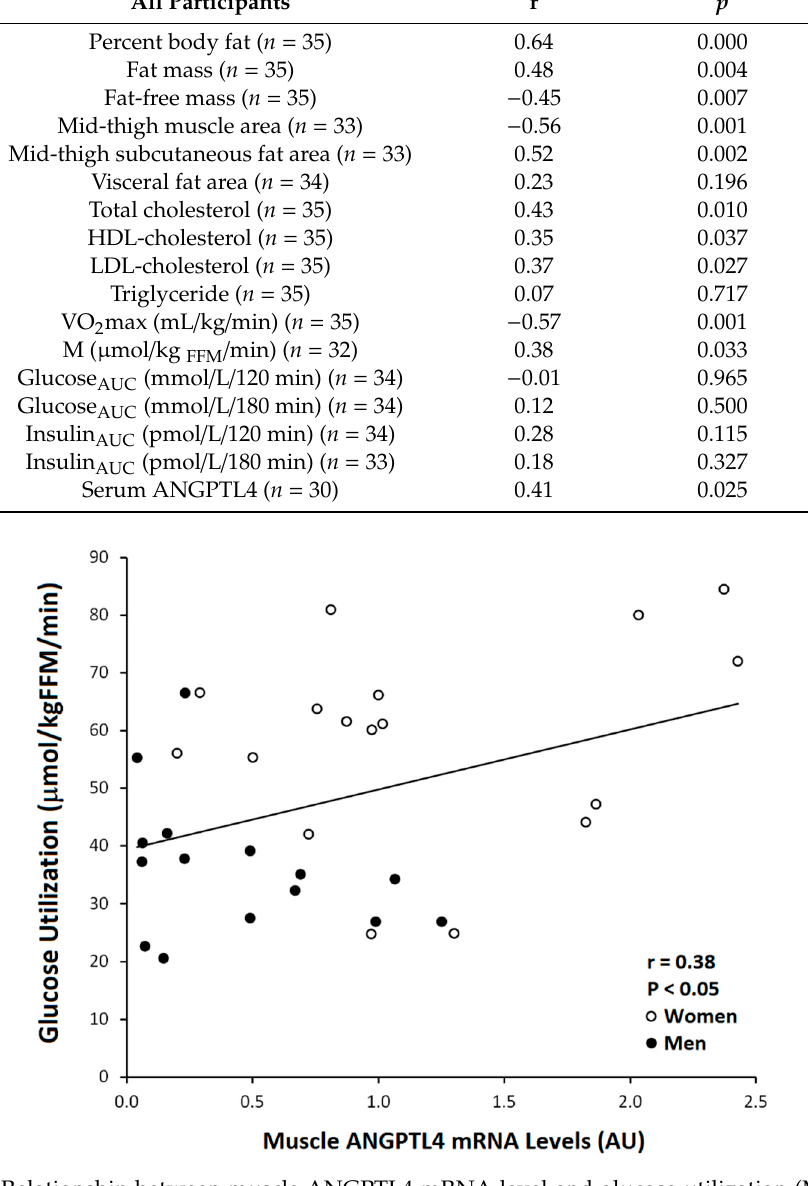
Table 3. Relationship between skeletal muscle ANGPTL4 mRNA and metabolic variables. All Participants